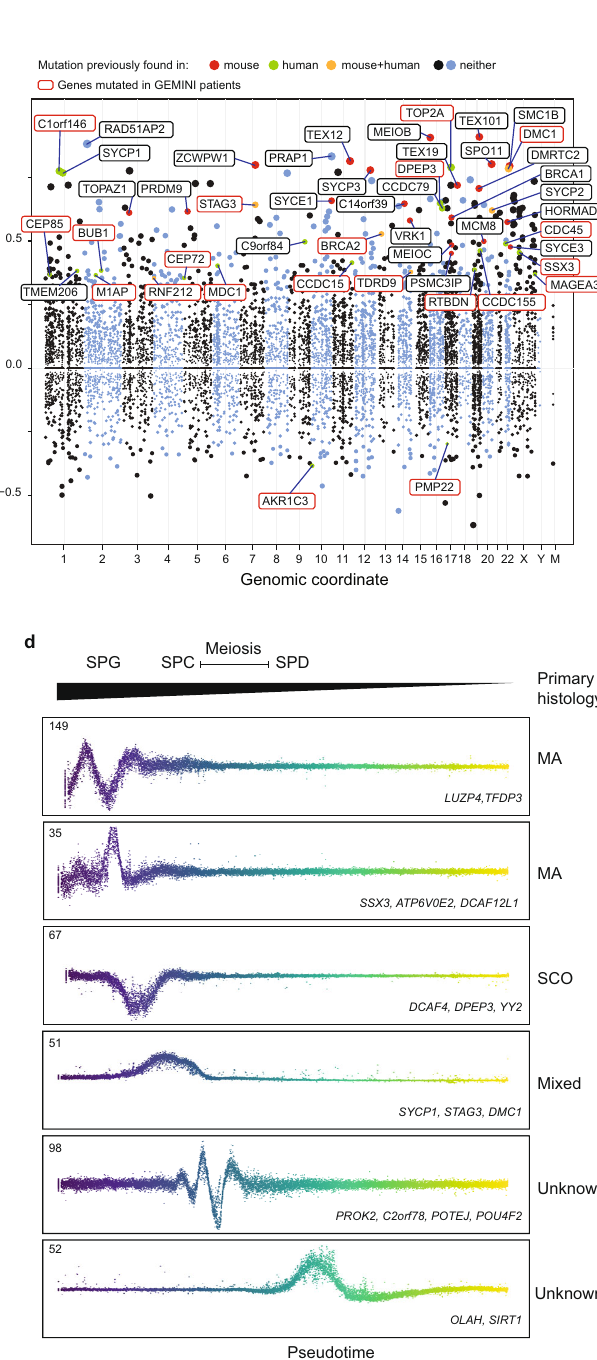
Fig. 5 | Using SDA components to de fi ne molecular subforms of genetic infertility. a Heatmaps summarizing the count of genes loading on each SDA component. Top: The distribution of NOA candidate genes across components is moresimilartothedistributionofmouseinfertilitygenes,comparedtogeneswith raredamaginggenotypesinpopulationcontrols( p =3×10 − 4 ,PearsonandFilon ’ sZ, two-sided). Bottom: Distribution of NOA candidate genes by testicular histology acrossSDAcomponents.GenesfoundinpatientswithMAshowadifferentpattern of expression compared to genes in SCO patients. SPG spermatogonia, SPC